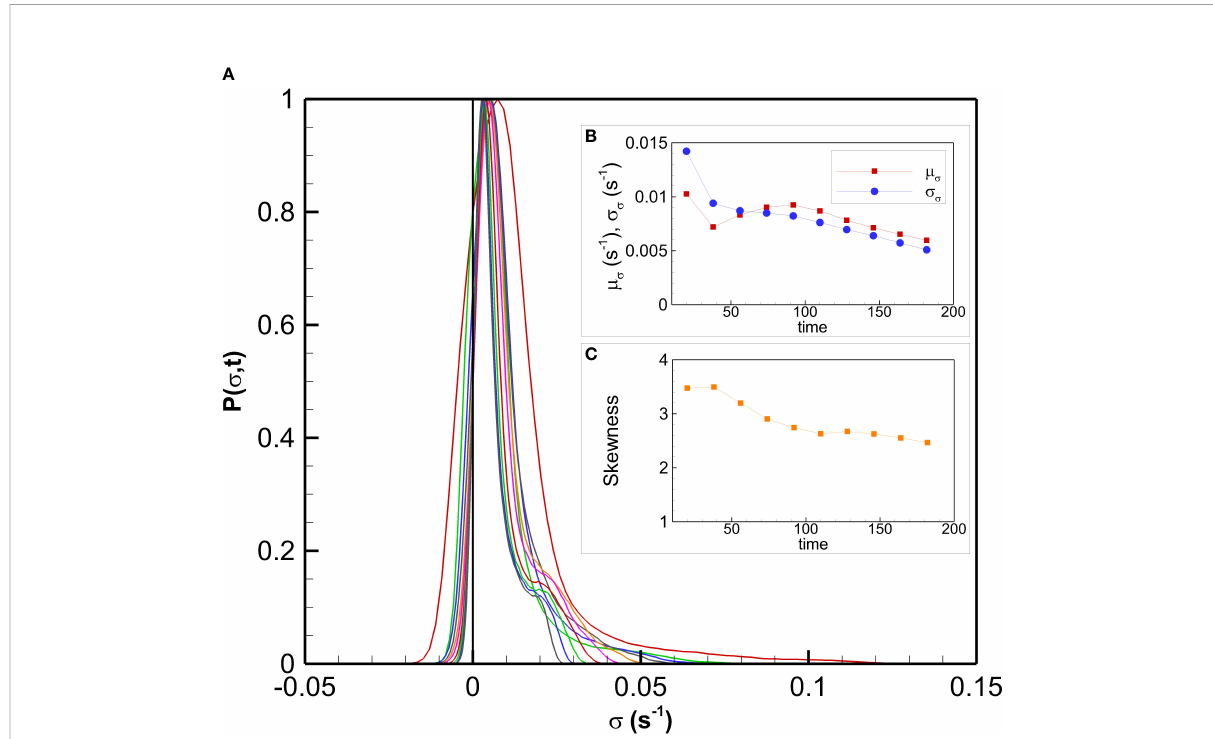
FIGURE 2 Experiment 24. Panel (A) The probability distribution of the Finite-Time Lyapunov Exponents. Panel (B) Mean value µ s and standard deviation ss of FTLE as function of the integration time. Panel (C) skewness parameter of the probability distribution as function of the integration